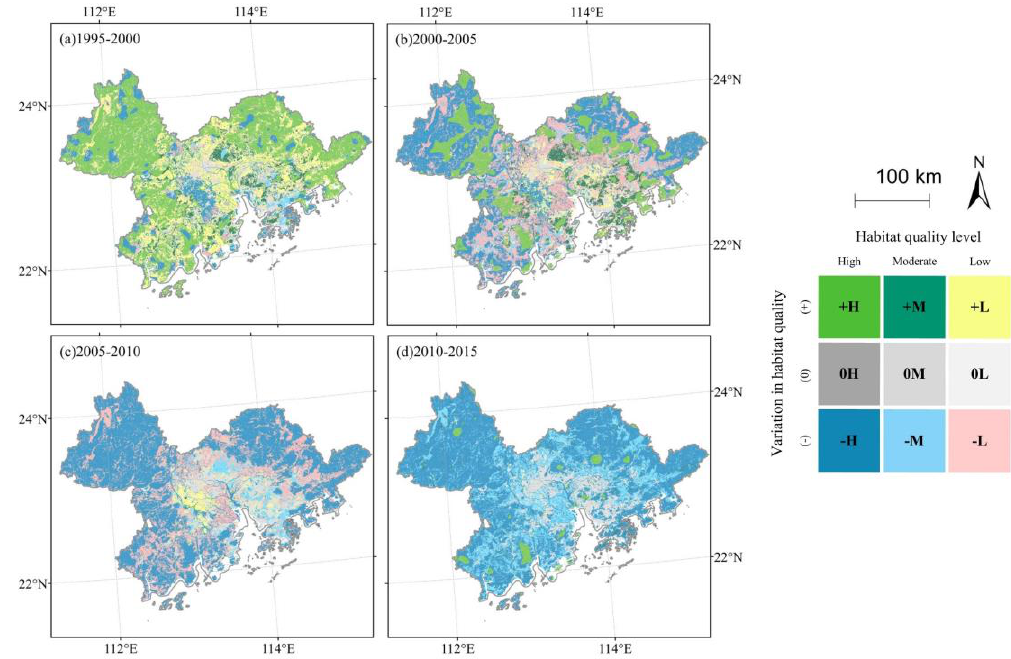
Figure 9. The variation in habitat quality in the Guangdong – Hong Kong – Macao Greater Bay Area (GBA) during the period from 1995 to 2015: ( a ) 1995 to 2000; ( b ) 2000 to 2005; ( c ) 2005 to 2010; ( d ) 2010 to 2015. Note: +H: the high level of habitat quality increased; 0H: the high level of habitat quality did not change; – H: the high level of habitat quality decreased; +M: the moderate level of habitat quality increased; 0M: the moderate level of habitat quality did not change; − M: the moderate level of habitat quality decreased; +L: the low level of habitat quality increased; 0L: the low level of habitat quality did not change; − L: the low level of habitat quality decreased.